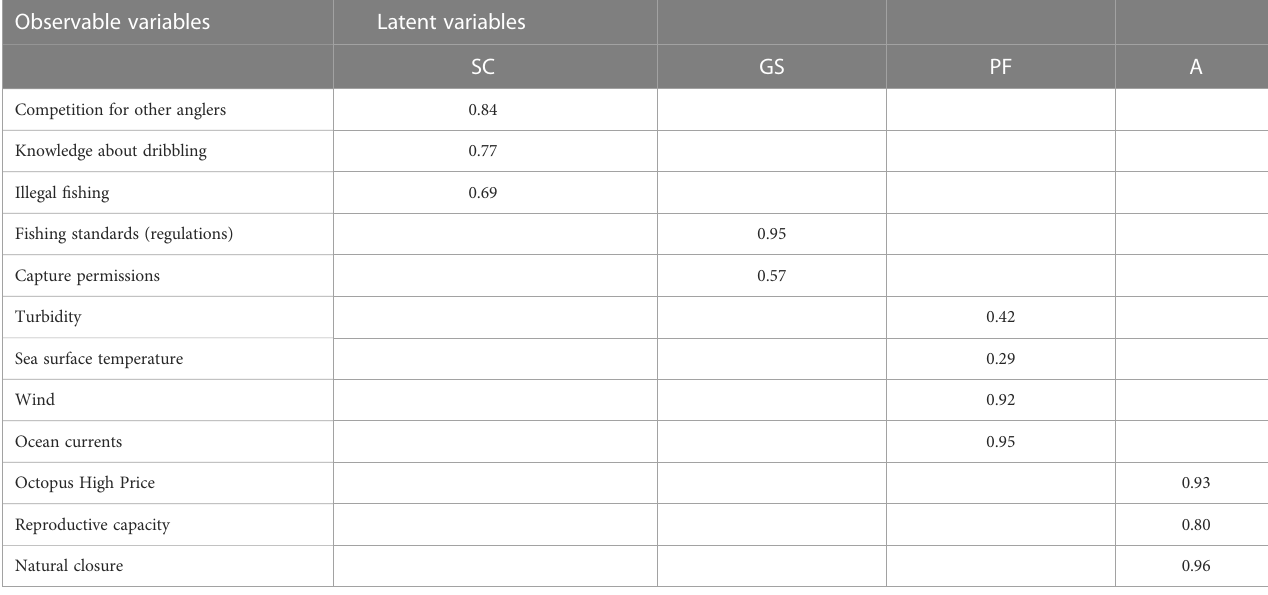
TABLE 2 Estimation of the measurement model (factorial